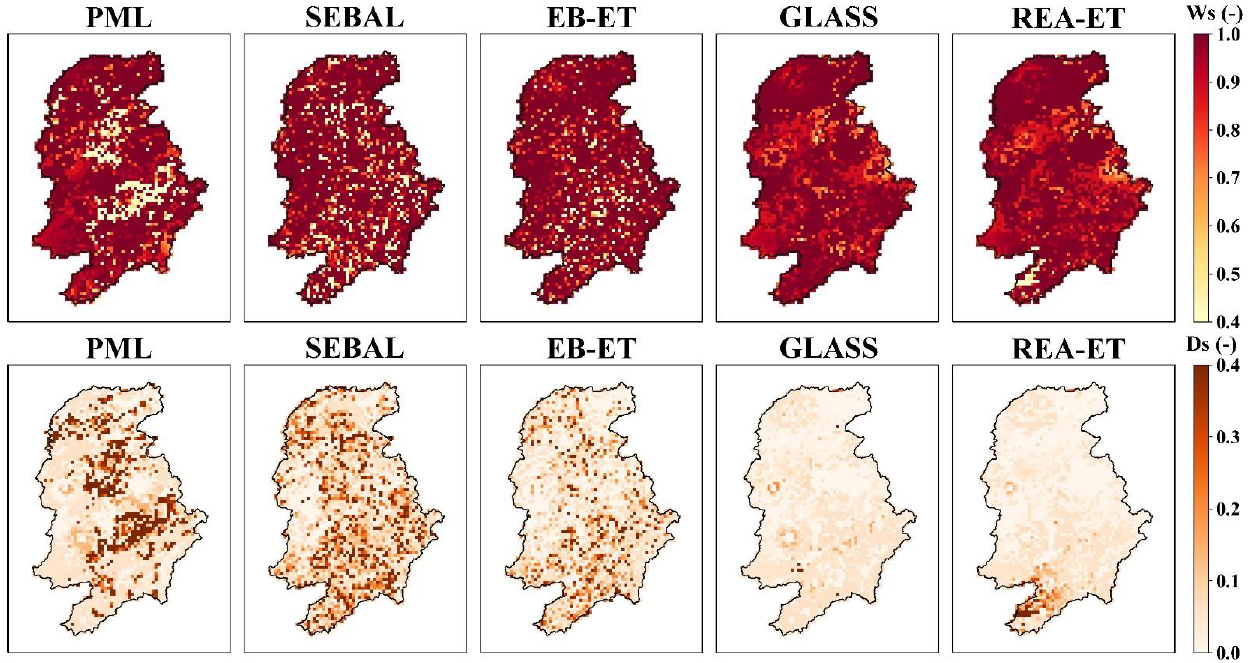
Figure 13. The distribution of the Ws and Ds hydrological parameters calibrated by Scheme 2 with different ET datasets.